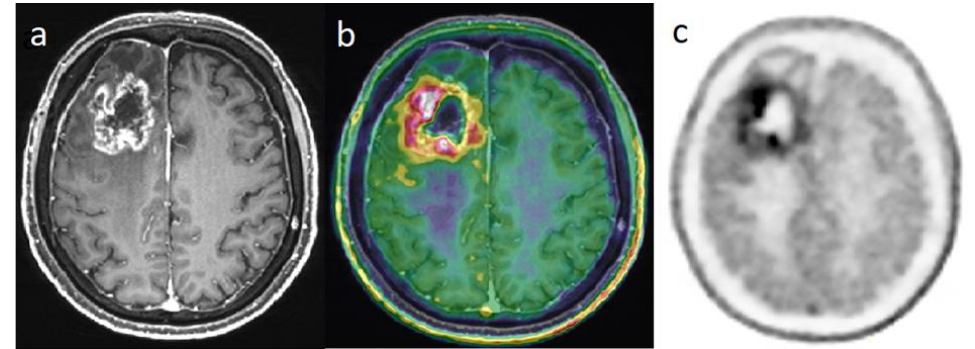
Figure 2. Differential diagnosis between recurrence versus radiation necrosis in a 70-year-old man who suffered from a right frontal glioblastoma IDH1-wt and was treated with surgery then chemoradiation with Temodal. Nine months later, there is an increase in edema in the site of the initial tumor. Post-enhancement T1-weighted MRI ( a ) revealed an increasing contrast enhancement which could correspond to a recurrence or a radionecrosis. [ 18 F]FDOPA PET images (fused with T1-weighted MRI ( b ) and PET only ( c )) showed an intense uptake of this lesion, with tumor/striata ratio = 1.5, suggesting tumor recurrence.